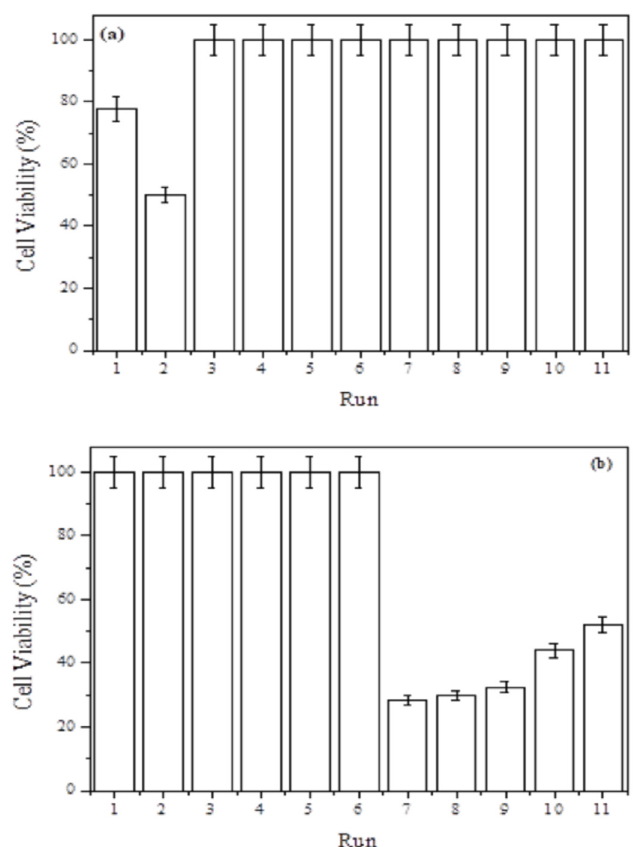
Figure 2. Viability of C. homilentoma strains (a) S-47 and (b) S-81, determined by methylene blue staining and Neubauer chamber